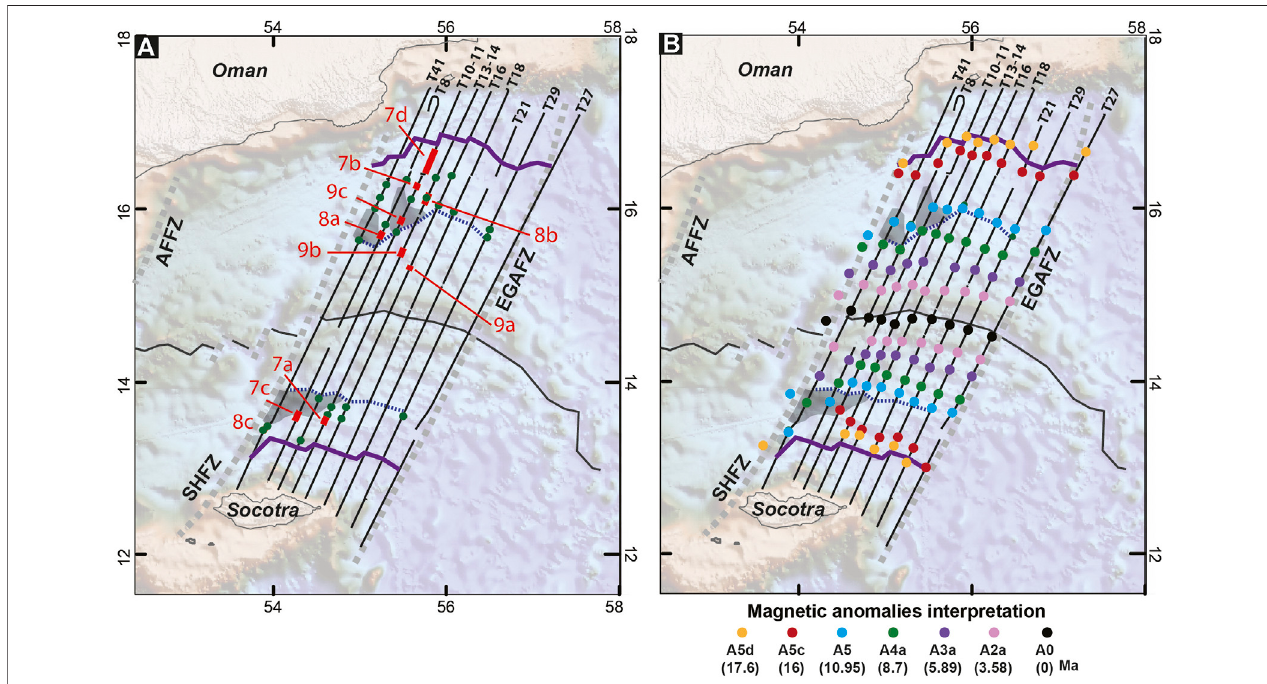
FIGURE 6 | (A) Map showing the location of the zooms displayed in Figures 7 , 8 , 9 . Green points show the location of the sedimentary deformation. (B) Map showing the correlation between the magnetic anomalies and the structural boundaries de fi ned by seismic observations. Violet line represents the location of the fi rst oceaniccrustidenti fi edontheseismic pro fi les[notethattheOCTlocationofNonnet al.(2017) followedexactlytheA5d magneticanomalyidenti fi cation fortheT21,T29 and T27 transects]. Dashed blue line represents the boundary between the old and young oceanic domains determined by seismic observations. Gray areas highlight the smooth and regular basement subdomain. Ages of the oceanic magnetic anomalies are from Cande and Kent (1995).